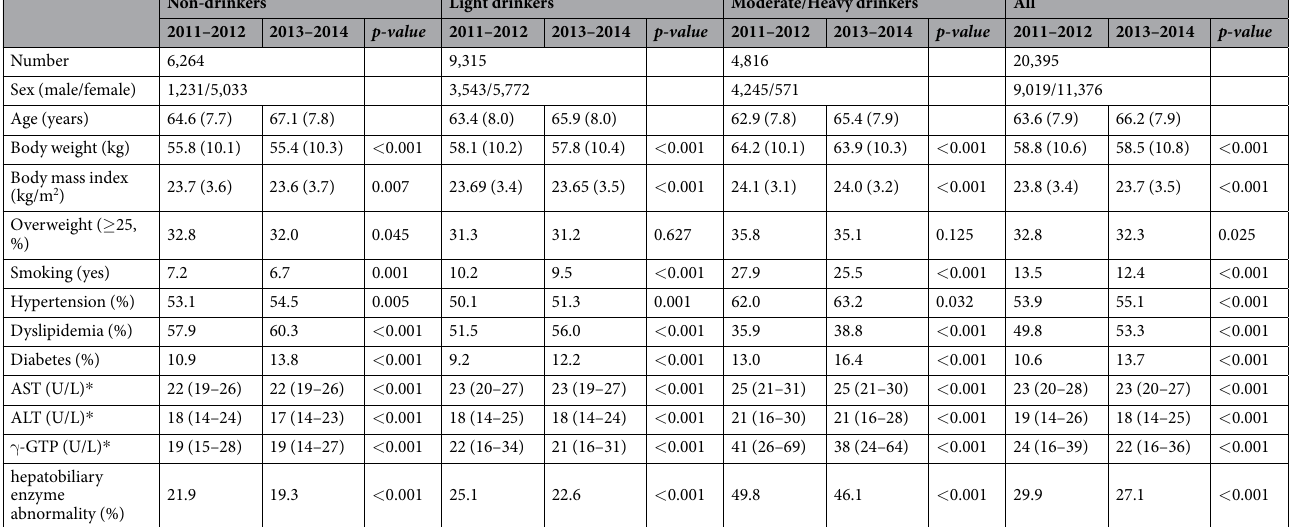
Table 1. Clinical and biochemical characteristics of 20,395 participants classified by alcohol intake status in 2011-2012 and 2013-2014. Data are mean values (standard deviation) or * median (interquartile range) for continuous variables, percentage values for categorical variables. AST, aspartate aminotransferase;